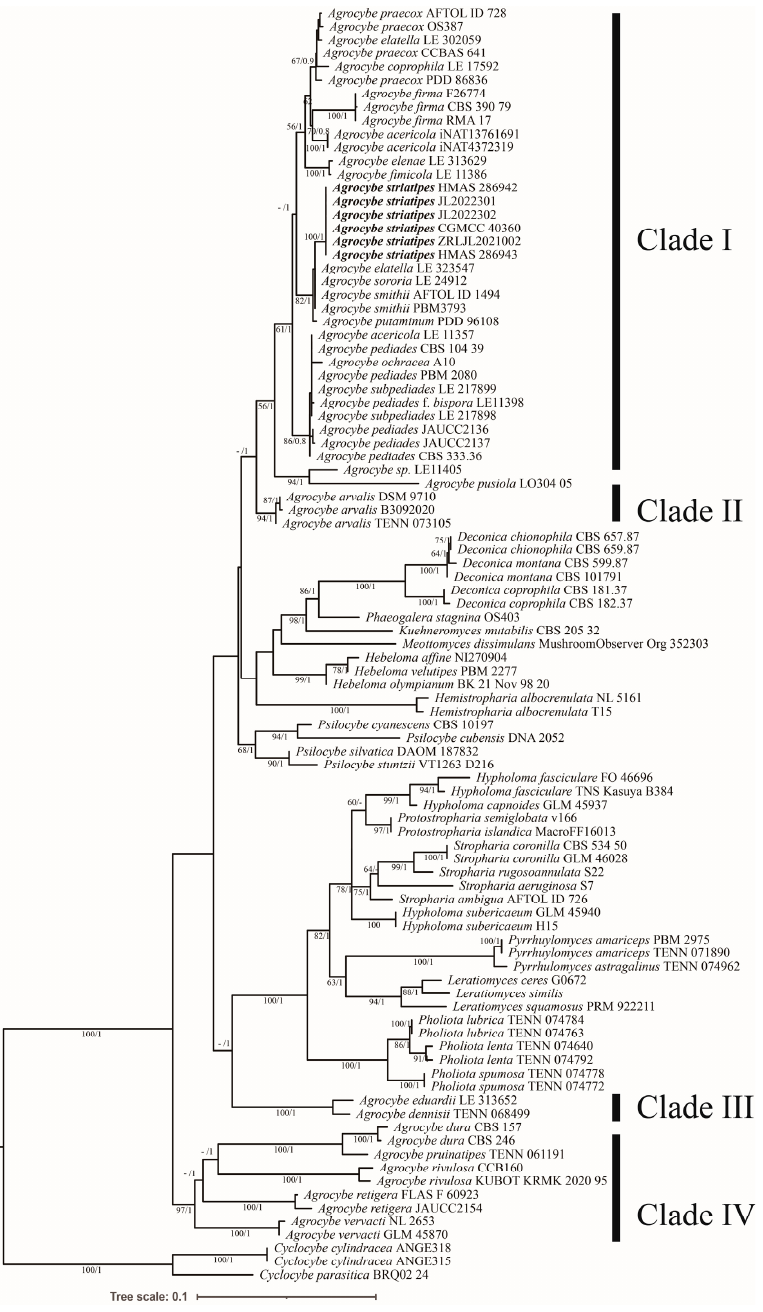
Figure 1. Maximum likelihood (ML) tree of Agrocybe based on ITS and nrLSU sequences data, including species selected from Hymenogastraceae and Strophariaceae, rooted with Cyclocybe . The bootstrap values and Bayesian posterior probabilities of more than 50%/0.8 (BS/PP) are indicated at the nodes.